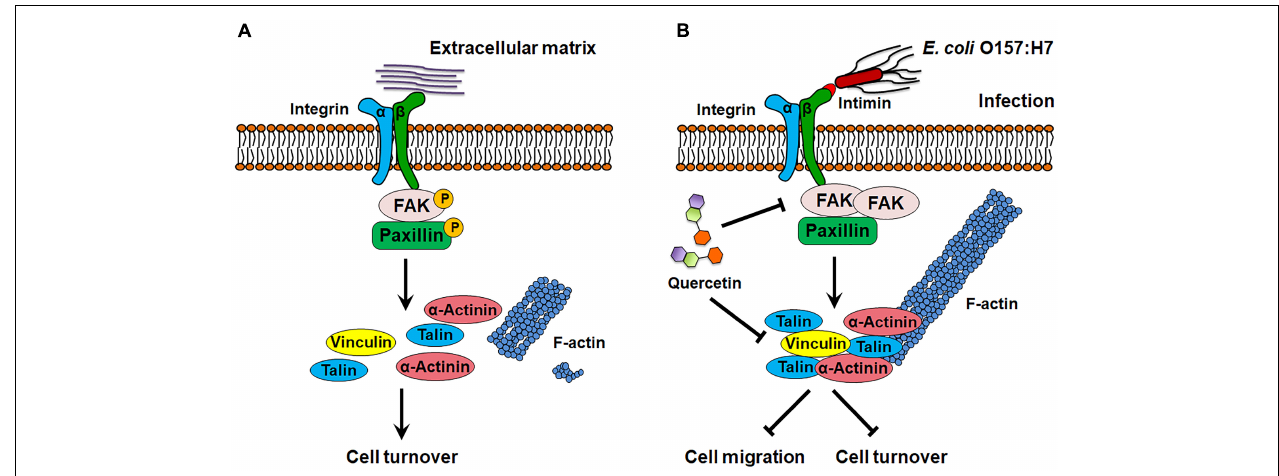
FIGURE 9 | Schematic diagram of E. coli O157:H7 colonization on host cell. (A) In normal state, FAK is activated by integrin β 1, which promotes focal adhesion turnover and cell motility. (B) E. coli O157:H7 can interact with host integrin β 1, which recruits FAK and paxillin, and inhibits their activation, thereby stabilizes focal adhesion and increases actin polymerization. Quercetin prevents integrin β 1 overexpression and focal adhesion formation as well as the association between integrin β 1 and FAK induced by infection. FAK, focal adhesion kinase. → Activate or promote,